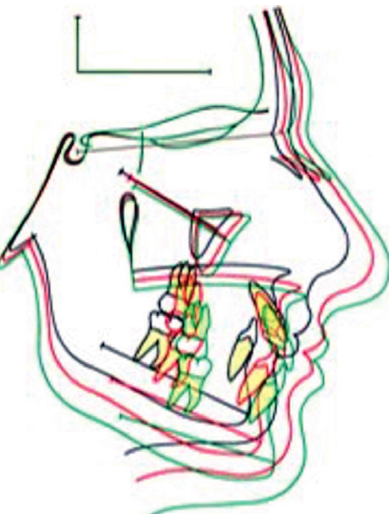
Figure 1: Example of 2D superimposition of cranial base